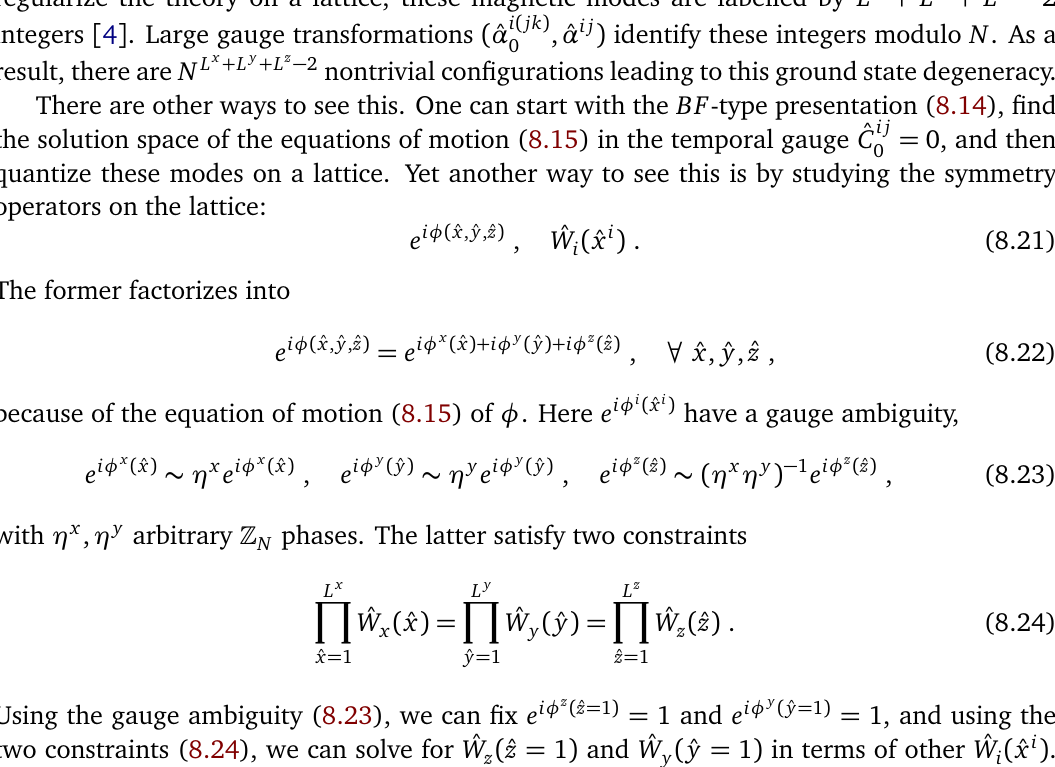
Figure 3: The global symmetries of the U ( 1 ) ˆ A -theory, the U ( 1 ) ˆ C -theory, the (cid:90) ˆ C -theory, and their relations. The electric dipole symmetry of the ˆ A -theory is gauged and therefore it is absent in the (cid:90) gauge theory. Note that the U ( 1 ) ˆ C -theory does N not have a magnetic